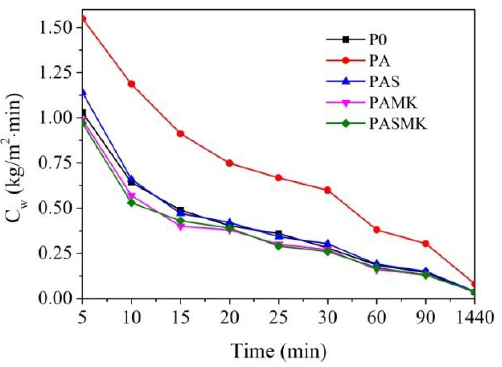
Figure 13. Capillary water absorption coefficient (C w ) of specimens P0 – PASMK.